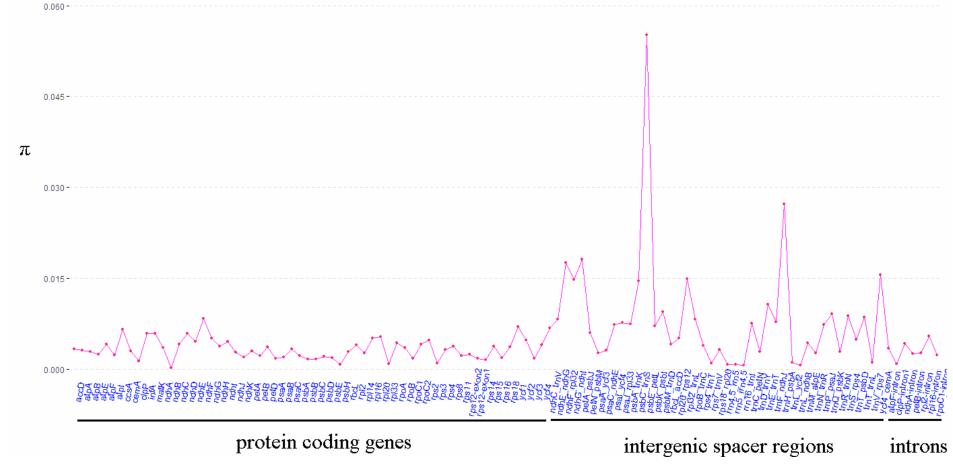
Figure 4. Nucleotide variability ( π ) values of 12 Litsea chloroplast